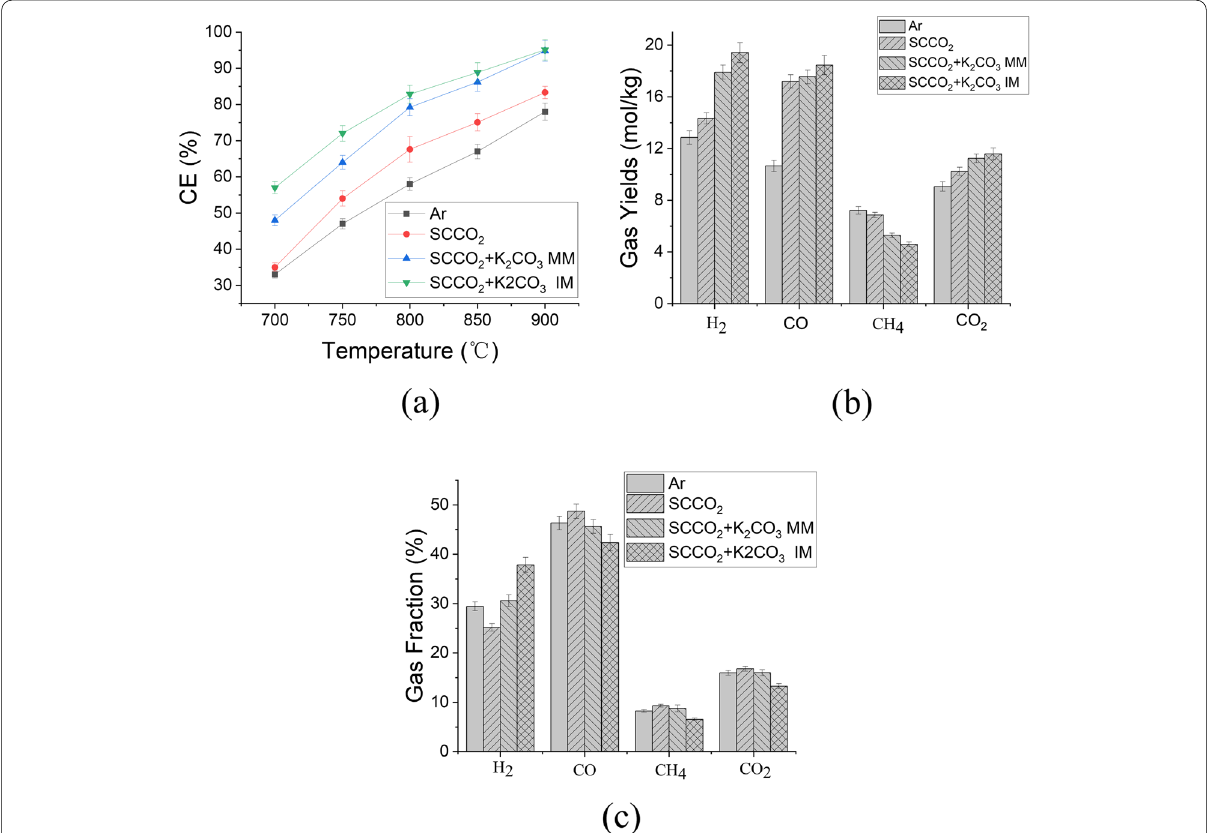
Fig. 7 Effect of different conditions on the supercritical carbon dioxide gasification of biomass (900 °C; 30 min): a CE; b gas yields of biomass gasification; c composition of the gas